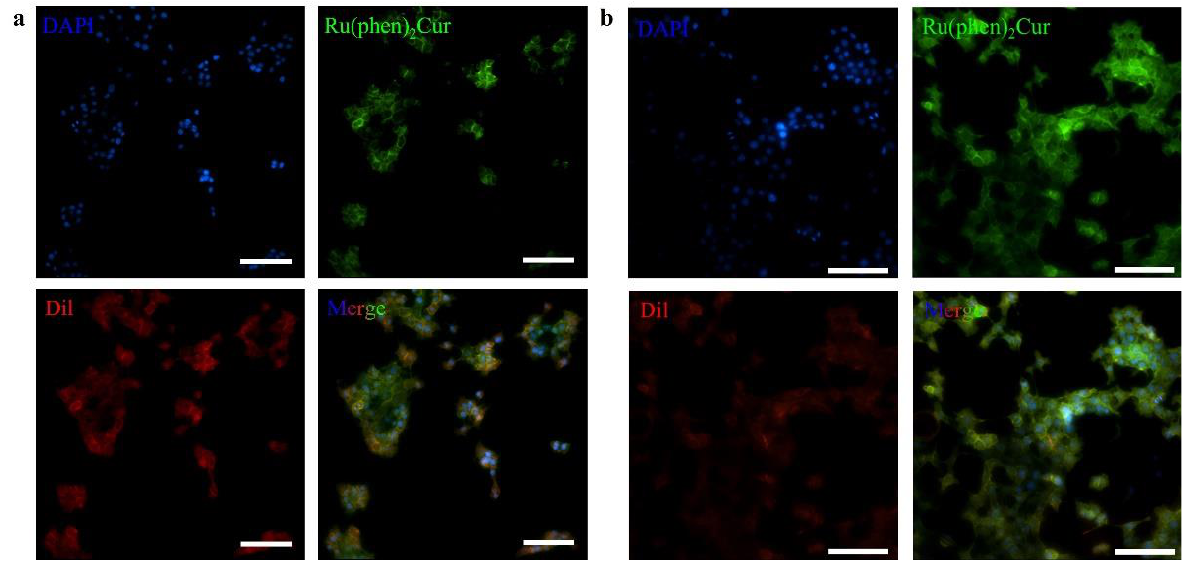
Figure 7. Photostability studies of Ru(II)-coumarin complexes. ( a ) Fluorescence imaging of 4T1 cells stained with DAPI (blue), Ru(II)-coumarin complexes (green) and Dil (red) before laser scans. Scale bar: 100 µ m. ( b ) Fluorescence imaging of 4T1 cells stained with DAPI (blue), Ru(II)-coumarin complexes (green) and Dil (red) after laser scans. Scale bar: 100 µ m.